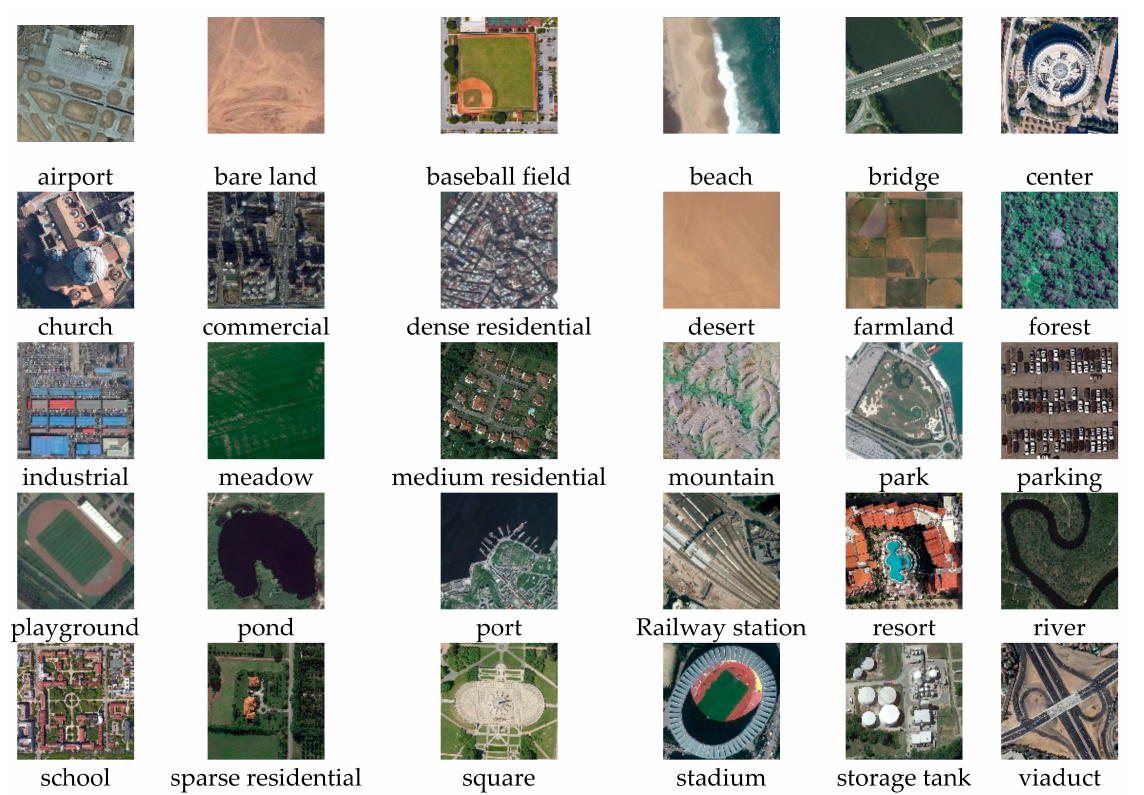
Figure 5. Example images of the AID